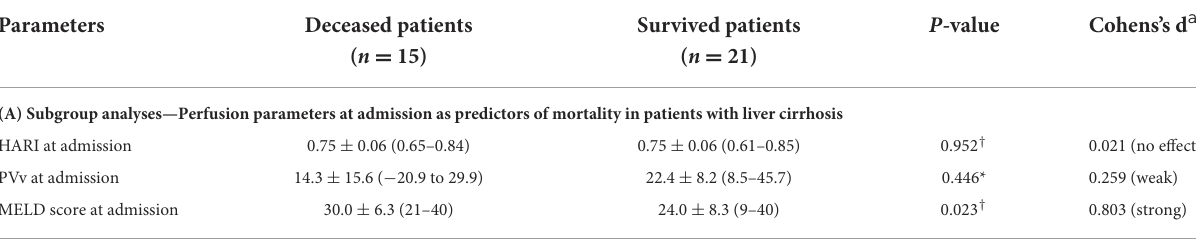
TABLE 6A Subgroup analyses—Liver perfusion parameters as predictors of mortality in patients with liver cirrhosis.